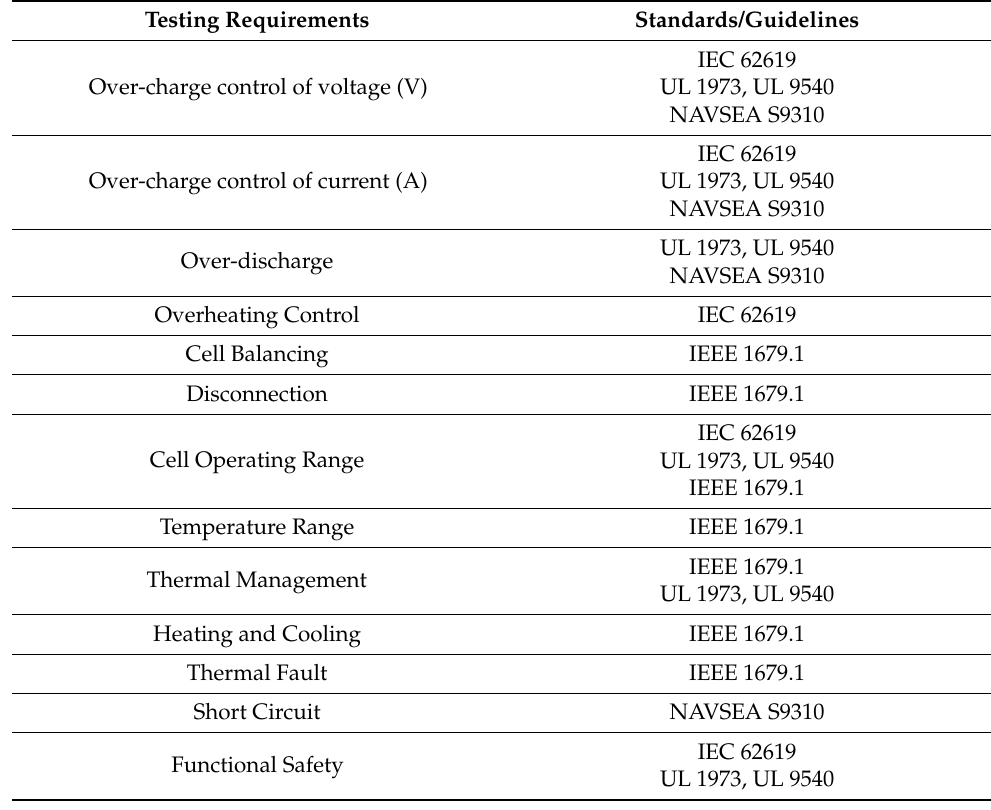
Table 7. Performance and safety tests for BMS in stationary